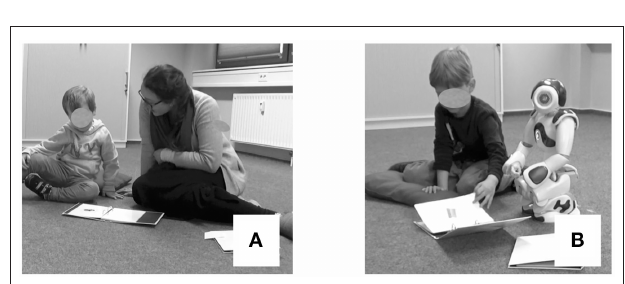
FIGURE 3 | Test situation with either the human (A) or the robot interlocutor (B) .